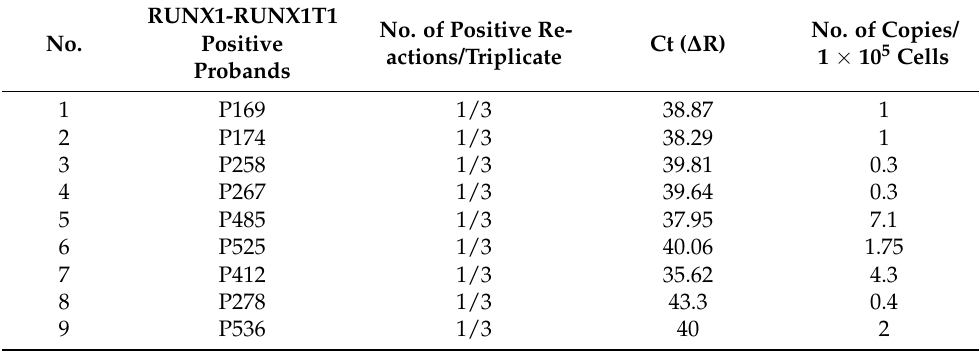
Table 1. RT-qPCR characteristics of RUNX1-RUNX1T1 positive samples validated further by standard PCR and sequencing.